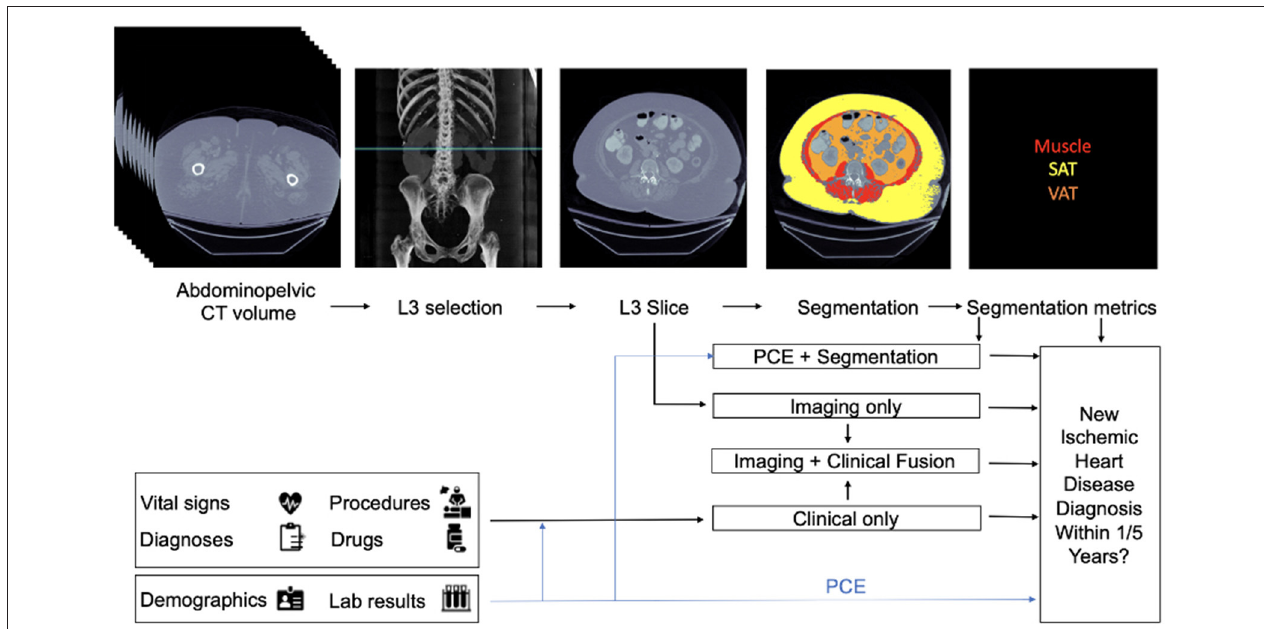
FIGURE 1 | Architecture of multi-modal data fusion combining Imaging and clinical data. Figure taken from Chaves et al. (15). In their described framework, readily available CT images are combined with clinical data (e.g. vital signs, diagnoses) to predict the likelihood of ischemic heart disease at 1 and 5 years.